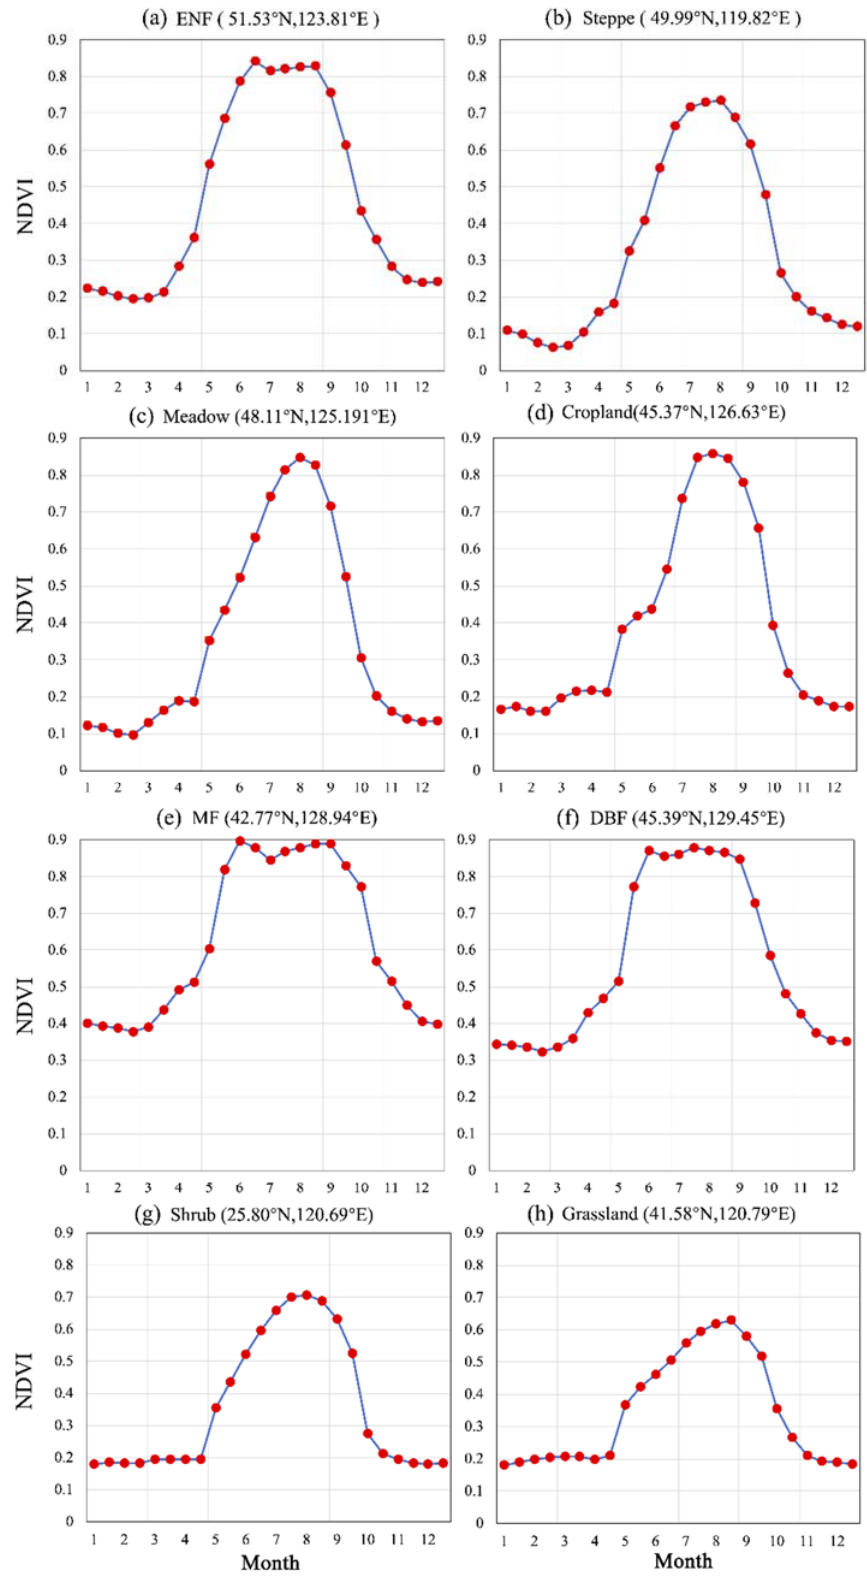
Figure A1. Seasonal growth process for typical vegetation covers in NEC (red point denotes multi-year averaged NDVI for a specific time point).